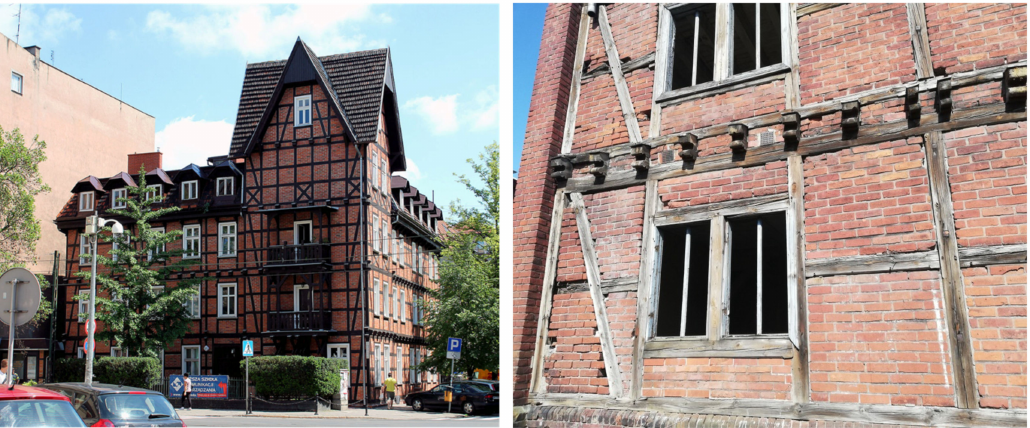
Figure 1. Taken as example, selected historic buildings with difficult access to sampling or testing (source: authors’ own